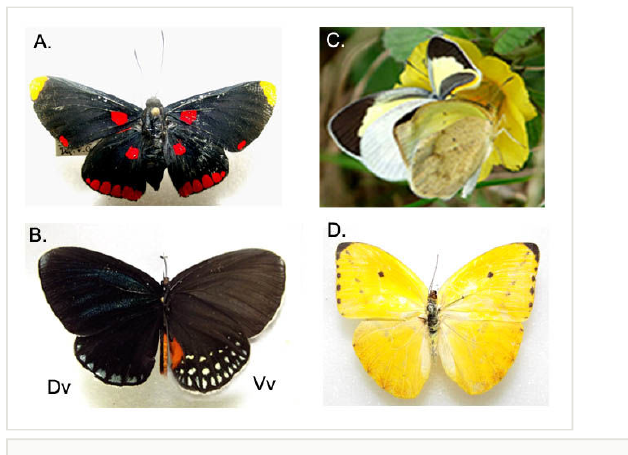
Figure 3. Riodinidae: A) Melanis pixie ; B) Eumaeus godartii Dv:dorsal; Vv:ventral. Pieridae: C) Eurema daira eugenia ; D) Phoebis argante .